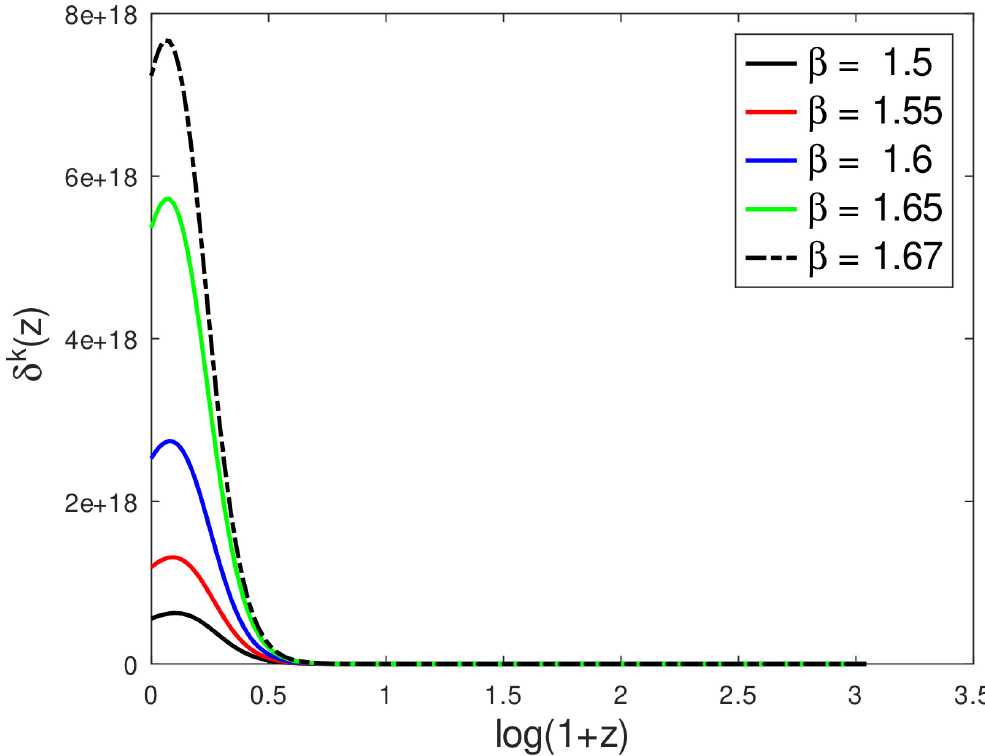
Figure 10. The variation of the matter density perturbations δ k ( z ) for a viscous Bianchi type-V cosmological model vs. redshift for γ = 50, α = 0.3, n = 0.2, and different values of β .